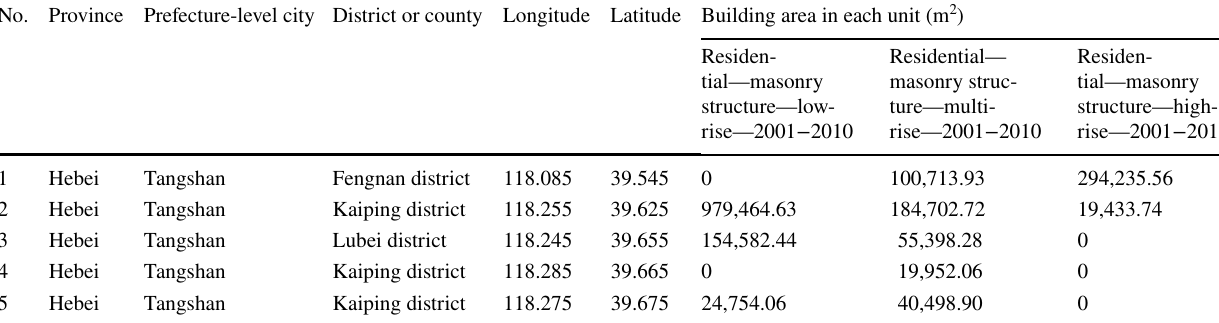
Table 1 Example of building exposure data for selected districts in Tangshan City,